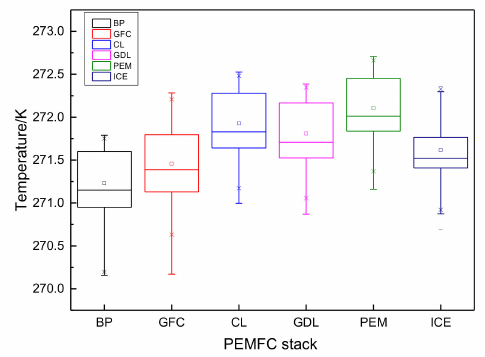
Figure 8. The temperature distribution in the vertical direction at 16th